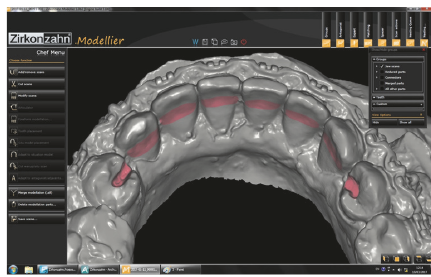
Figure 1: CAD/CAM zirconium bar survey.